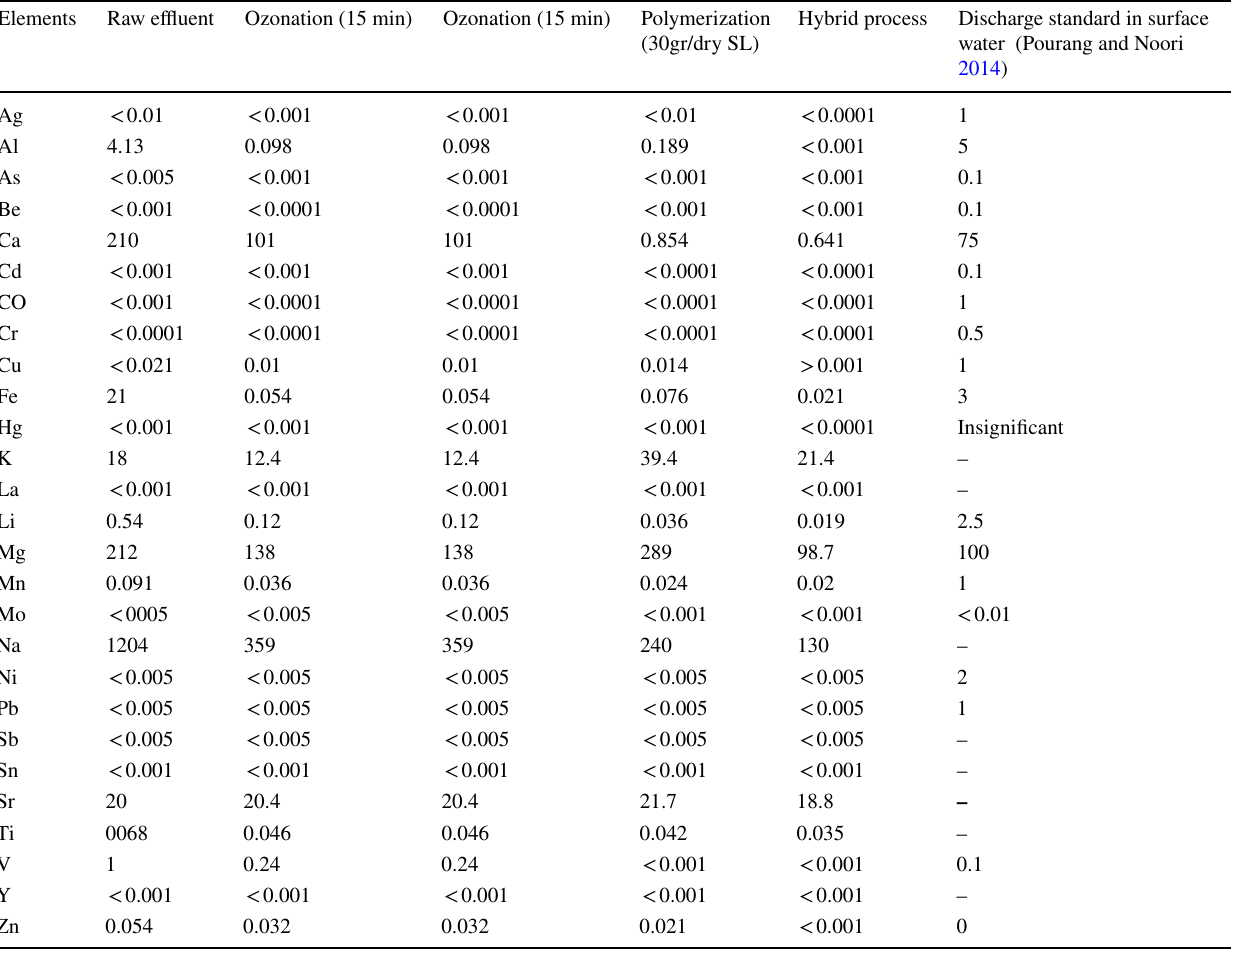
Table 3 Concentration of elements and metals in raw effluent in comparison with ozonation, polymerization and simultaneous ozonation and polymerization processes